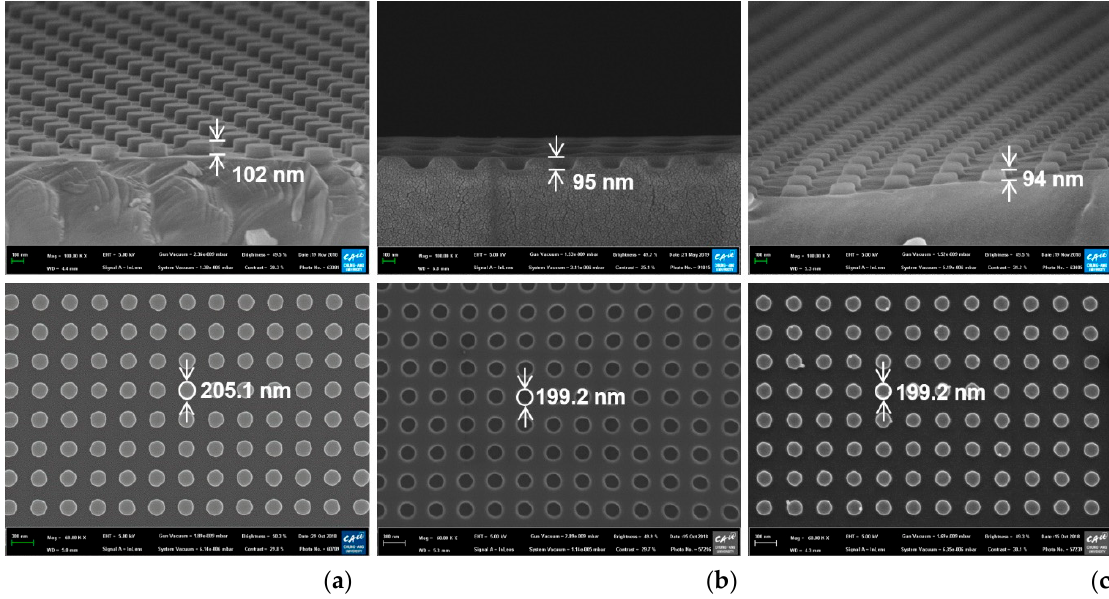
Figure 2. Top-view (bottom) and cross-sectional (top) scanning electron microscope (SEM) images of ( a ) the silicon master, ( b ) the polymer template, and ( c ) the UV-imprinted nanodot pattern.